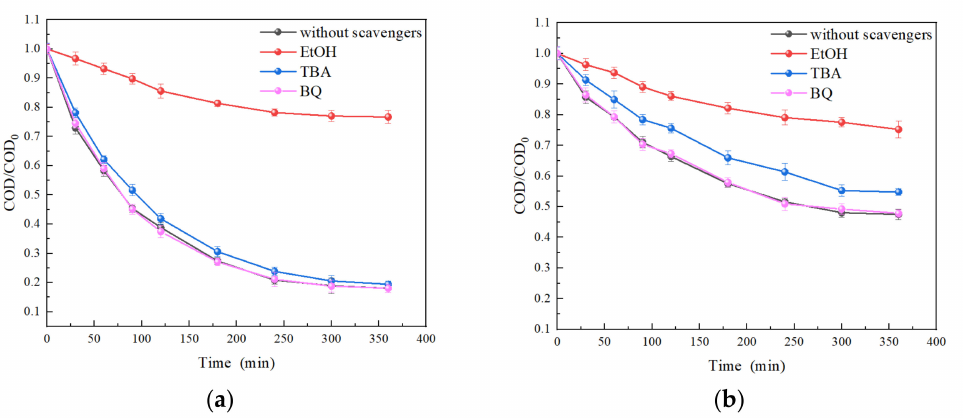
Figure 10. Radicals’ contribution in electrically assisted ZVI/UV synergistic activated PS system. Reaction conditions: PS/12COD ratio = 1; ZVI dosage = 1.5 g/L; current density = 62.5 mA/cm 2 , reaction time = 6 h; molar ratio COD: scavenger = 1:50. Initial pH = 3.0 ( a ). Initial pH = 9.0 ( b